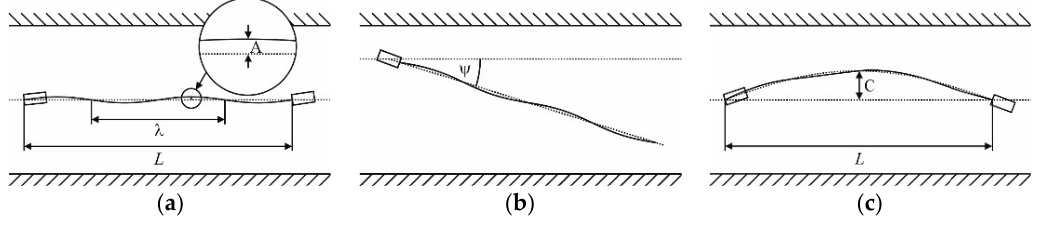
Figure 9. Vehicle movement on the measuring section: ( a ) low values of rolling error ψ = 0; ( b ) low values of rolling error ψ ≠ 0; ( c ) high values of rolling errors, L —direct distance between the start and endpoints of the route, A —amplitude of oscillation, C —deviation, λ —wavelength, ψ —angle deviation.